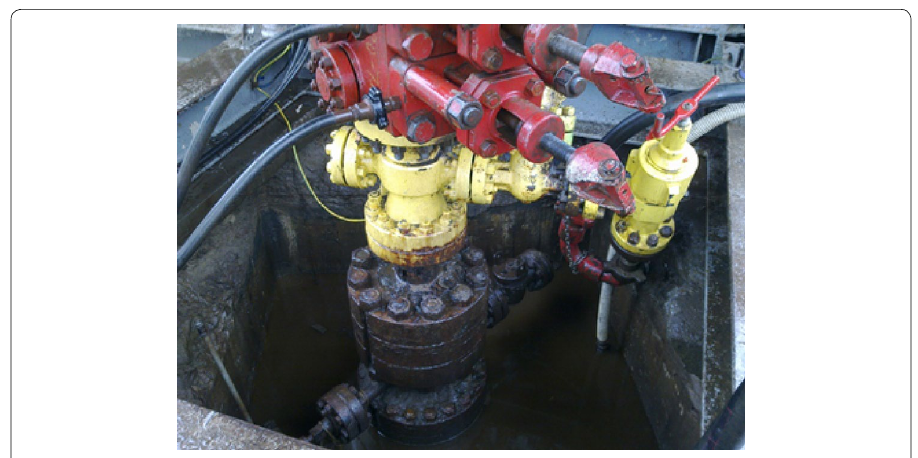
Fig. 12 Lower part of the original Poręba Wielka IG-1 wellhead together with a flange connection to the casing head (photo: B. Bielec)